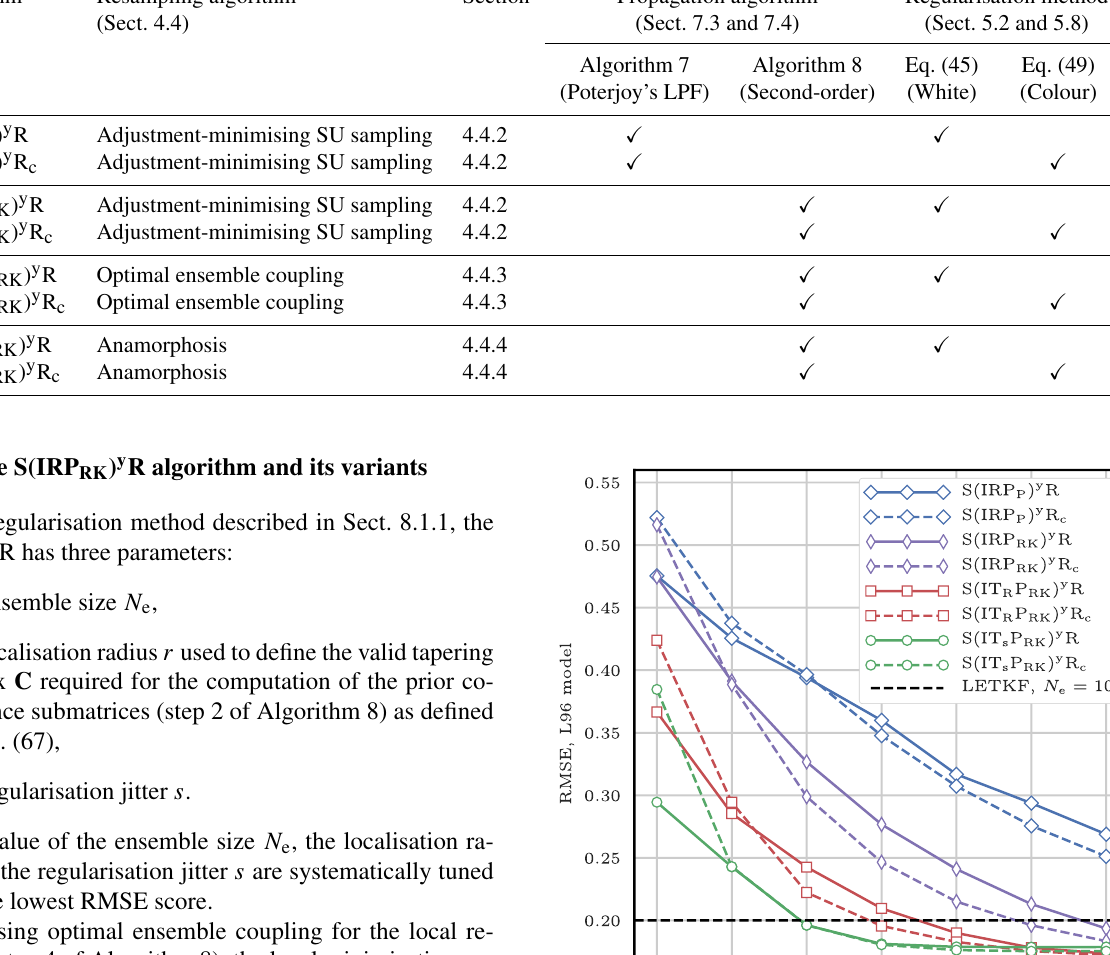
Table 4. List of all LPF y algorithms tested in this article. For each algorithm, the main characteristics are reported with appropriate references. Algorithm